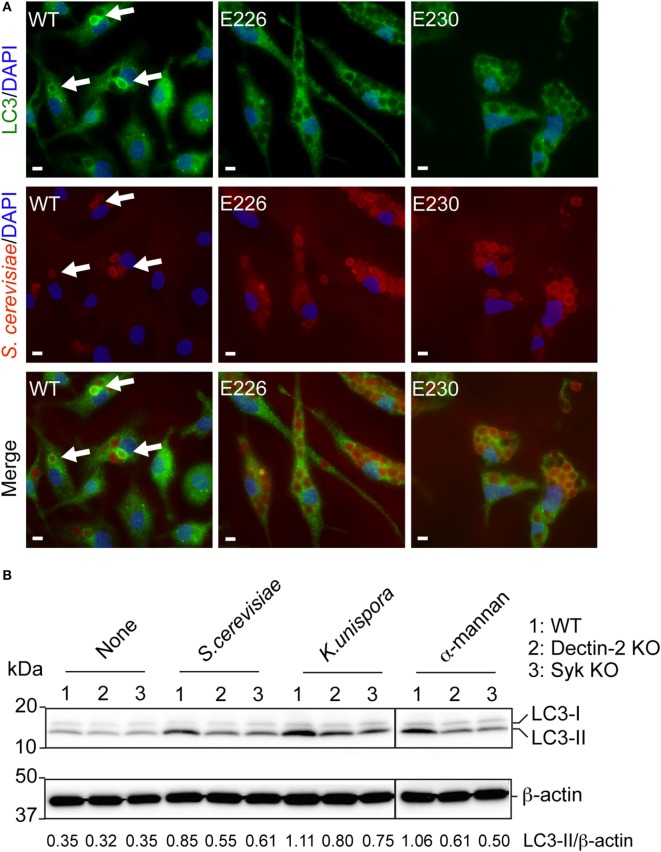
Commensal yeasts induce LAP and LC3 activation. (A) WT, E226, and E230 BMDCs were incubated with Alexa555-labeled and PFA fixed S. cerevisiae at a MOI of 10 for 2 h. Cells were then fixed, permeabilized, and stained with anti-LC3 Ab and analyzed. White bar indicates 5 µm. Arrows show LC3 recruitment to S. cerevisiae. (B) WT, Dectin-2 KO, and Syk KO BMDCs were incubated with the indicated yeasts at a MOI of 5 or α-mannan for 1 h. Cells were lysed, and the proteins were separated by SDS-PAGE and blotted to a PVDF membrane. The membrane was probed by anti-LC3 Ab. The band intensity ratio of LC3-II over β-actin is shown in the bottom. Data shown are one representative experiment and reproducible at least two independent experiments.